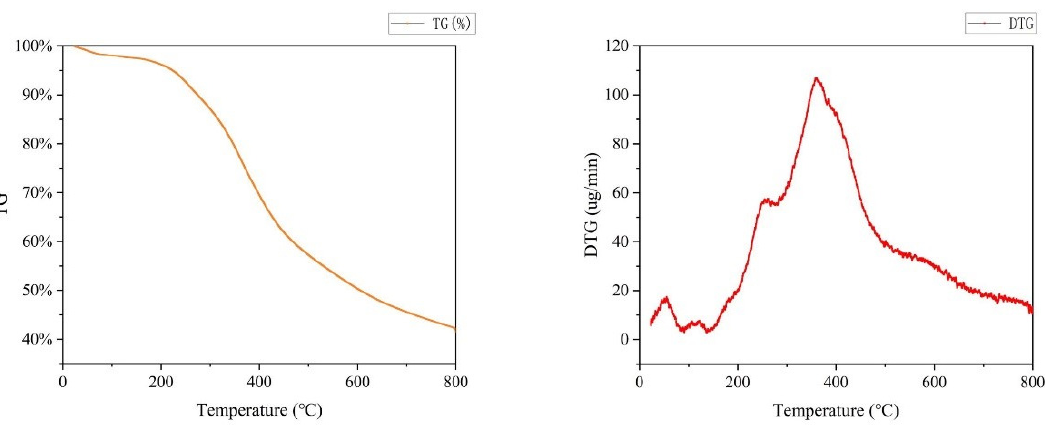
Figure 8. TG and DTG curve of lignin.